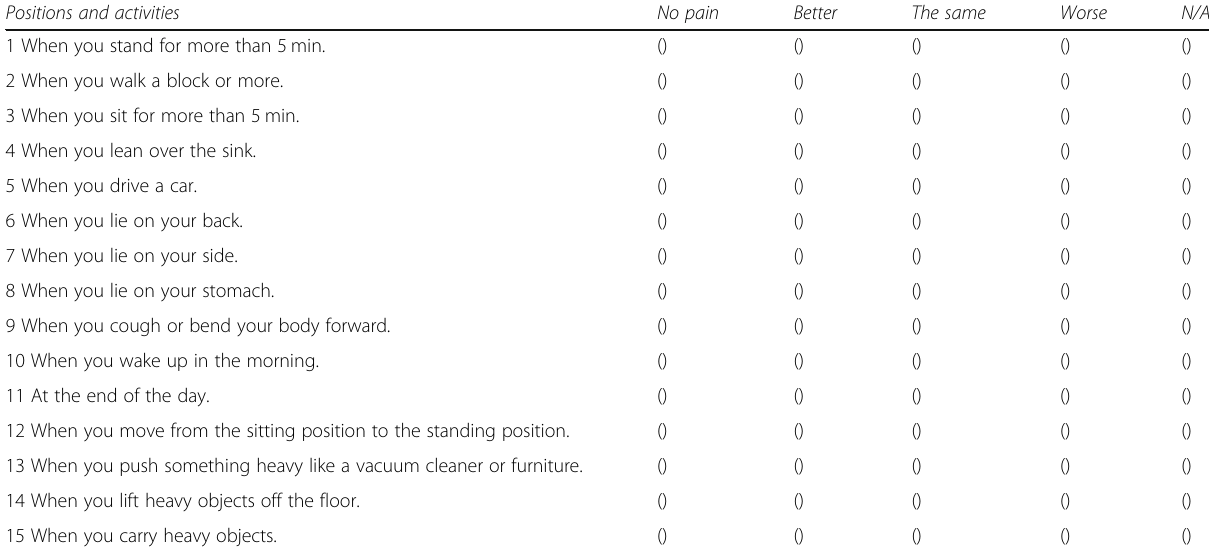
Table 1 Final version of the Pain Response to Activity and Position Questionnaire (PRAP) Positions and